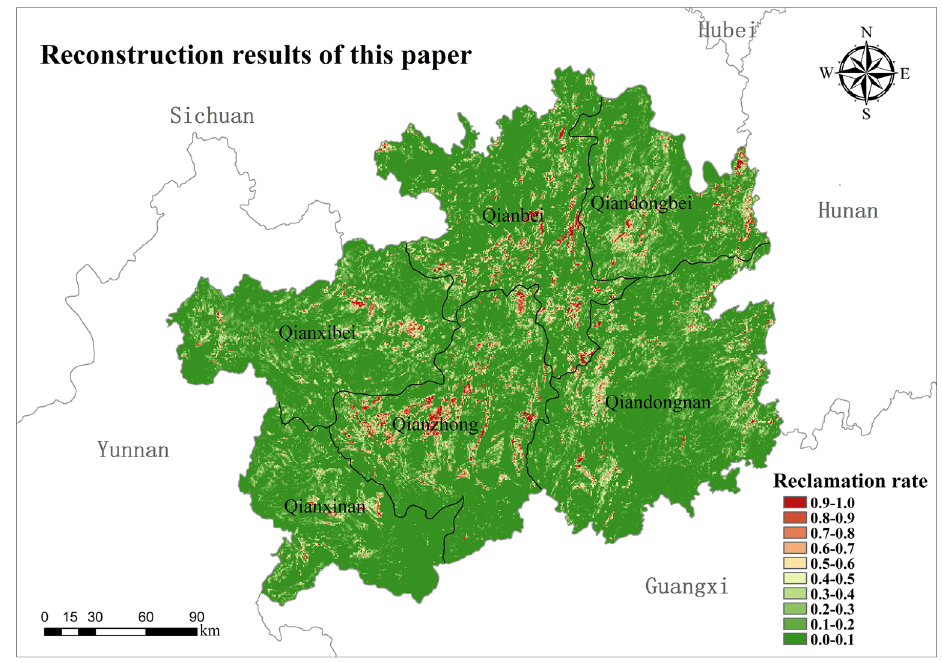
Figure 5. Reconstruction results of the cropland pattern in this paper (map created using ArcGIS 10.8).